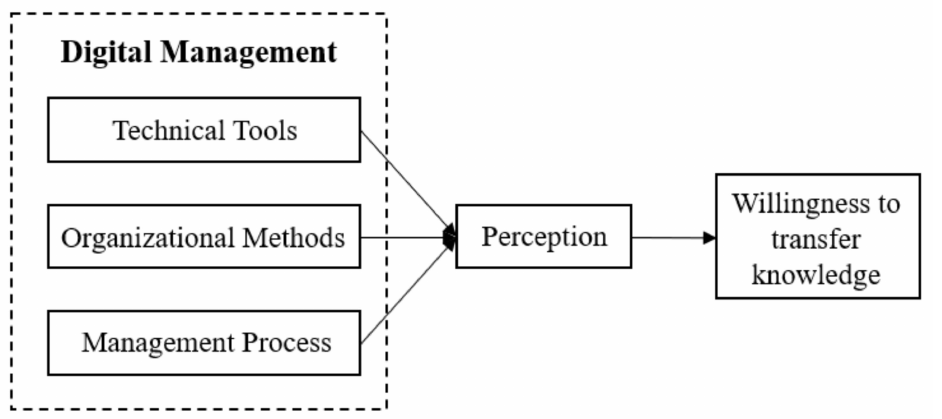
Figure 2. Research model of willingness to transfer knowledge factors within engineering consult- ing